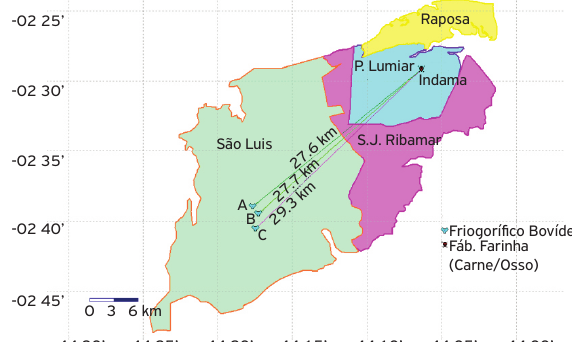
Figura 1. Distribuição espacial dos frigoríficos que abatem bovinos na cidade de São Luís, Maranhão, e distância desses em relação à fábrica de subprodutos, 2012.